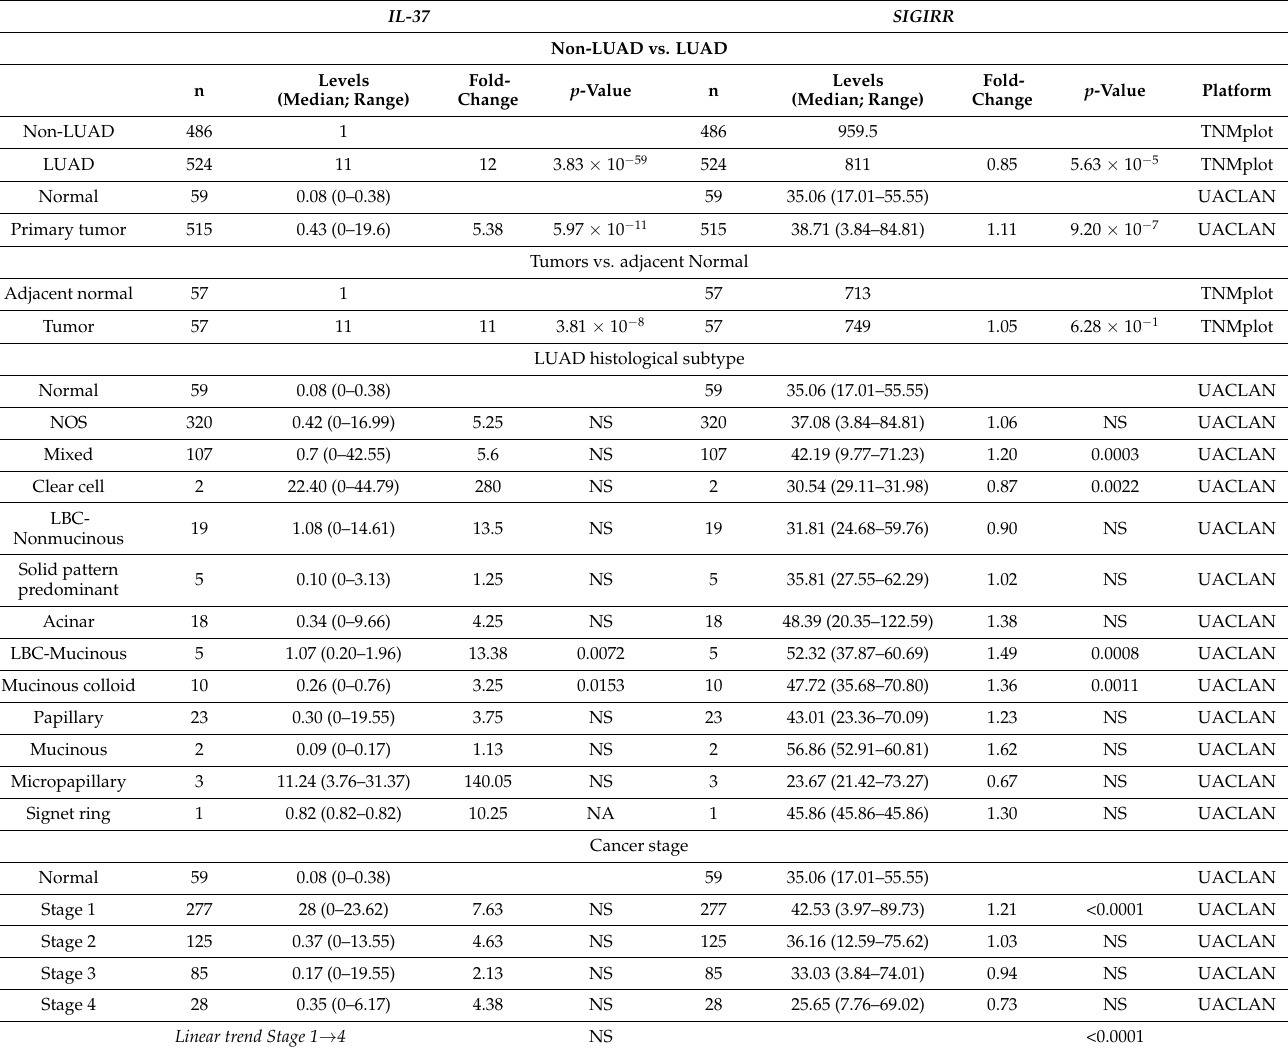
Table 2. Differential distribution of IL-37 and SIGIRR mRNA levels in LUAD vs. non-LUAD tissues or among LUAD tumors of different histological type or stage. Number of patients in each group, the median levels of expression and their range (where available), fold-change over non-LUAD/normal samples, p -values, and the webtool used for the analysis (TNMplot [32], UACLAN [33]) are reported. IL-37 SIGIRR Non-LUAD vs.